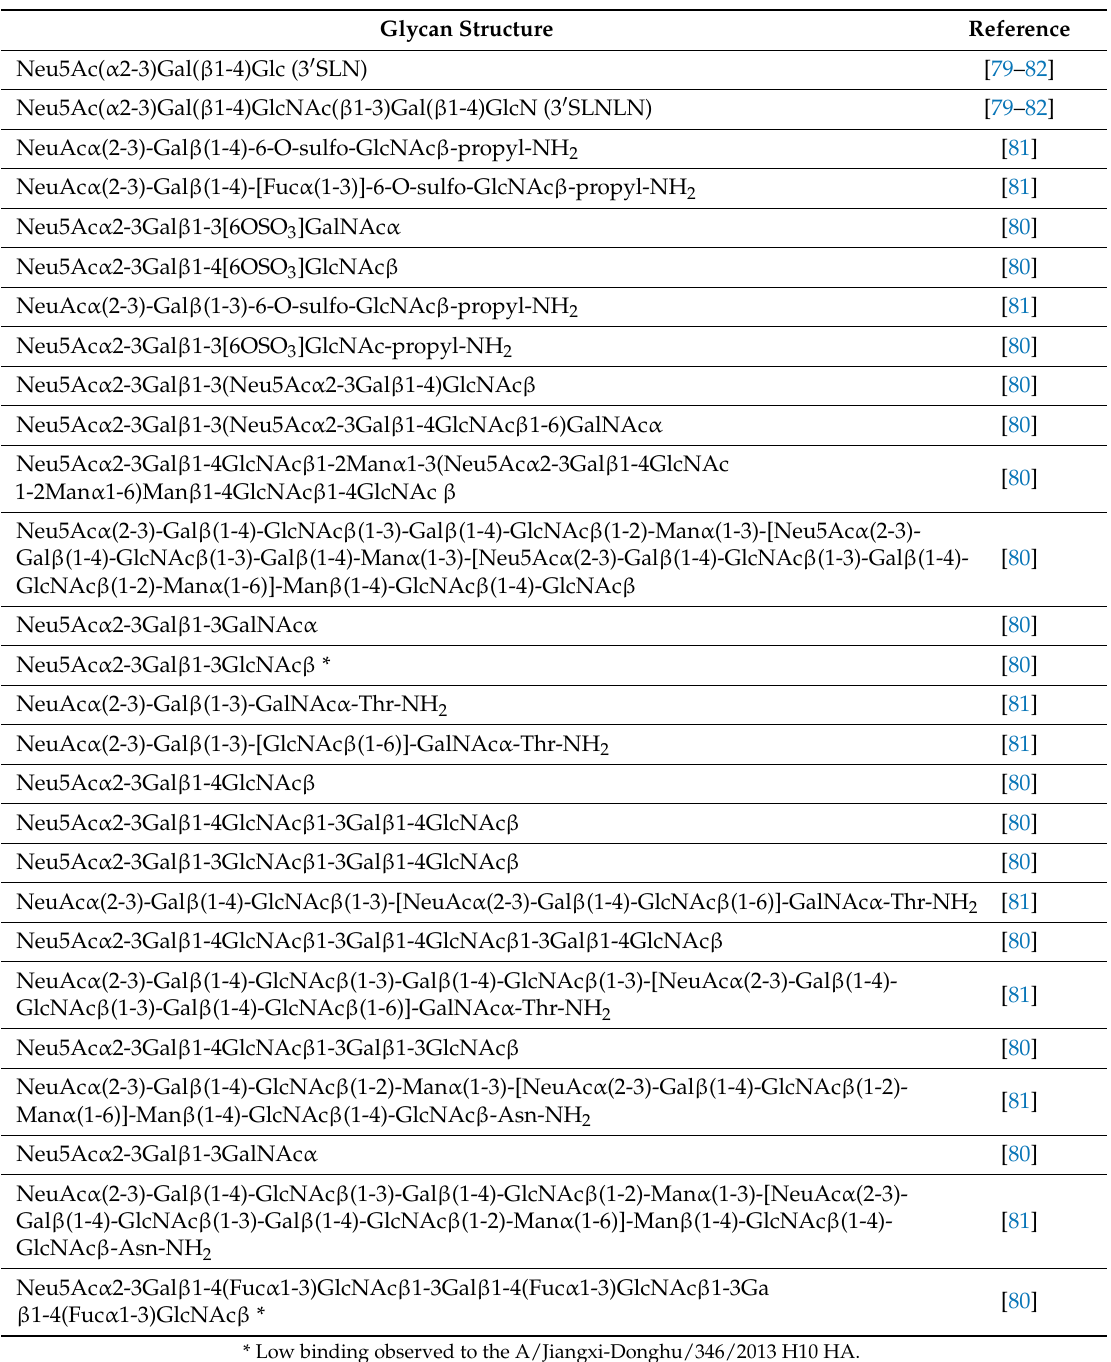
Table 1. α 2,3 sialyl-glycan specificity of the human A/Jiangxi-Donghu/346/2013 and avian A/green-winged teal/Texas/Y171/2006 H10